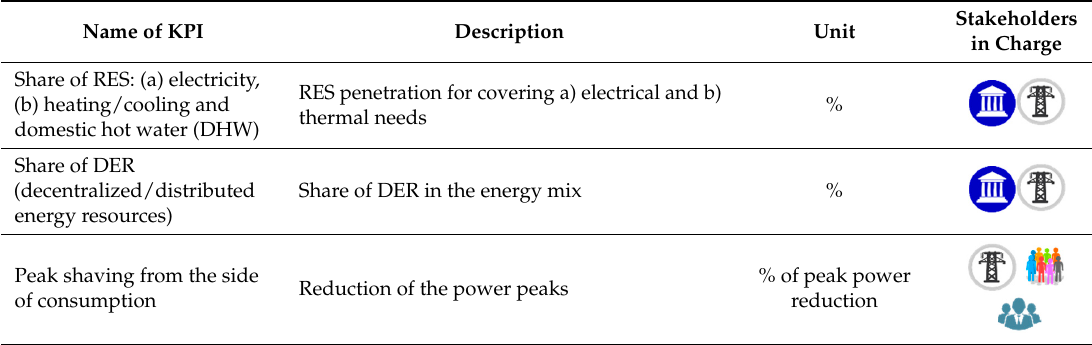
Table 4. List of Technical KPIs.